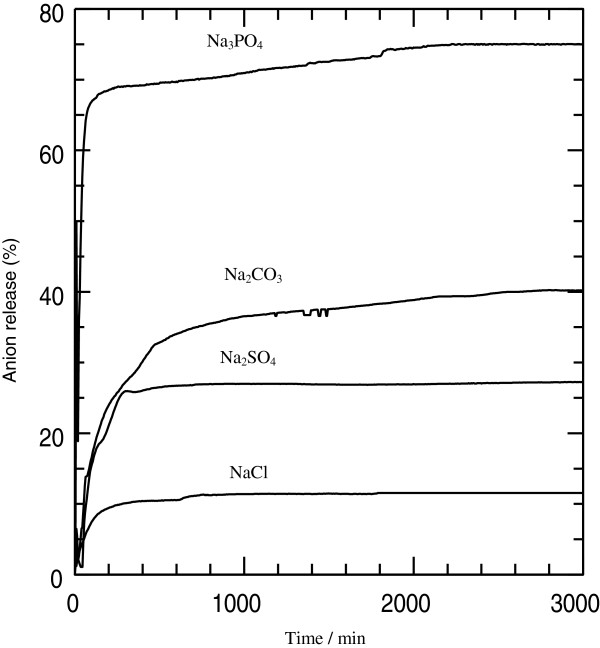
Release profiles of 3,4-D from N3,4-D into 0.005 M aqueous solutions containing PO43−, CO32−, SO42−, and Cl−.